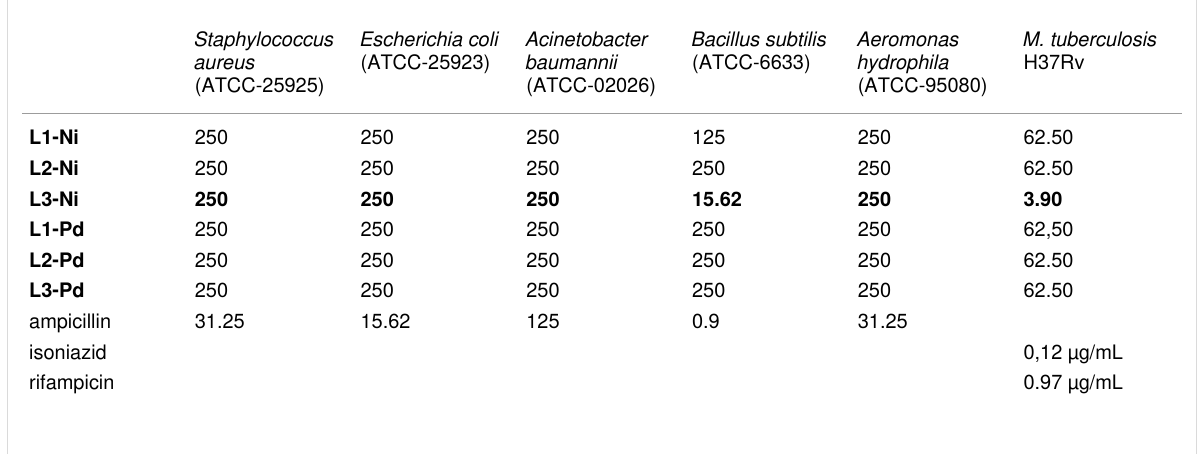
Table 1: Antibacterial and antituberculosis activity ( μ